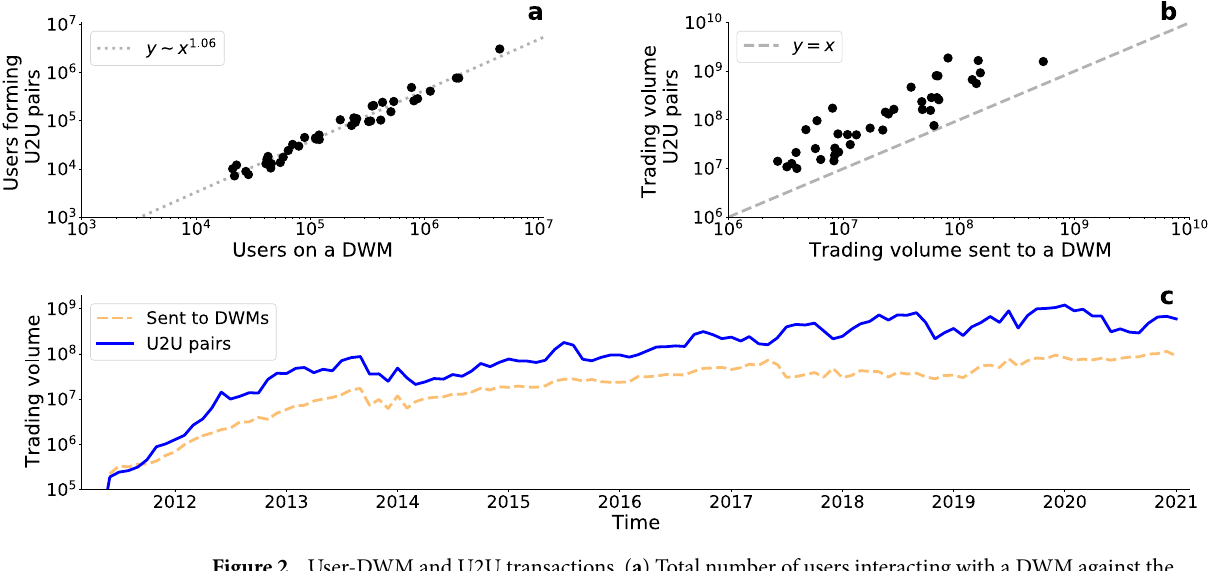
Figure 2. User-DWM and U2U transactions. ( a ) Total number of users interacting with a DWM against the total number of users forming U2U transactions. The dotted line corresponds to the result of a fitted power law function. ( b ) Trading volume in dollars sent to a DWM compared with the total trading volume in its surrounding U2U transactions. The dashed line is the bisector and allows to easily compare the two trading volumes. ( c ) Total monthly trading volume sent to all DWMs and exchanged in all unique U2U pairs. We do not include the trading volume received from DWMs because it is essentially equivalent to the volume sent to